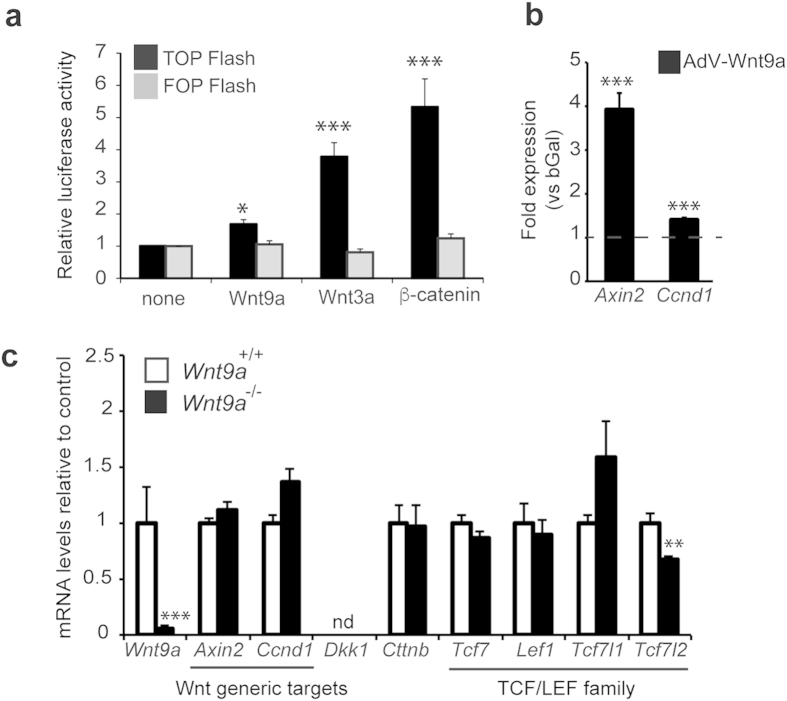
Involvement of TCF/LEF factors in Wnt9a-dependent signalling.(a) mPAC cells were transfected with the TCF-dependent luciferase reporter vector TOP-Flash (black) or its mutated version FOP-Flash (grey) and expression vectors for Wnt9a, Wnt3a or a mutant form of Ctnnb1 lacking aminoacids 29–48. Results are expressed relative to the backbone vector, normalized to 1. Bars represent mean ± SEM for at least 4 independent experiments, each performed in duplicate *p < 0.05 and ***p < 0.001 vs backbone. (b) mPAC cells were transduced with an adenovirus expressing Wnt9a (AdV-Wnt9a) or AdCMV-bGal as control and total cellular RNA was isolated 48 h after virus treatment. mRNA levels for Axin2 and Ccnd1 were quantitated by qRT-PCR and normalized to tbp. Values are expressed relative to cells treated with AdV-bGal, which are given the value of 1. Bars represent mean ± SEM for at least 7 independent experiments. ***p < 0.001 vs bGal. (c) Total pancreatic mRNA from Wnt9a+/+ and Wnt9a−/− animals was collected at E15.5 and expression for the indicated genes was assessed by qRT-PCR and normalized with tbp. Results are presented relative to Wnt9a+/+ given the value of 1. Bars represent mean ± SEM for 7 Wnt9a+/+ and 6 Wnt9a−/− animals. *p < 0.05 vs Wnt9a+/+. Note that Dkk1 mRNA was not detected in either knockout or wild-type pancreas (ND = not detected).